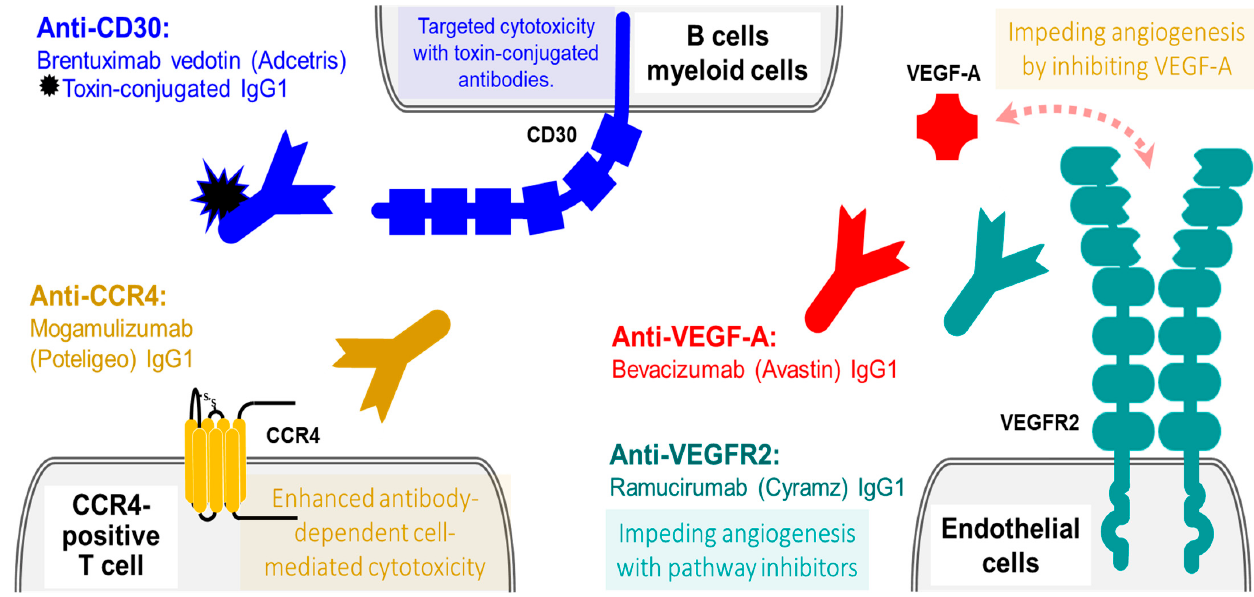
Figure 4. Antibody therapies against other blood cell antigens and vasculature. Targeting CD38 with cytotoxic drug-conjugated antibodies ( top left ). Targeting CCR4 with monoclonal unconjugated antibodies ( bottom left ). Targeting VEGF pathways with monoclonal unconjugated antibodies against VEGF-A growth factor and with monoclonal unconjugated antibodies against VEGFR2 receptor ( right ).